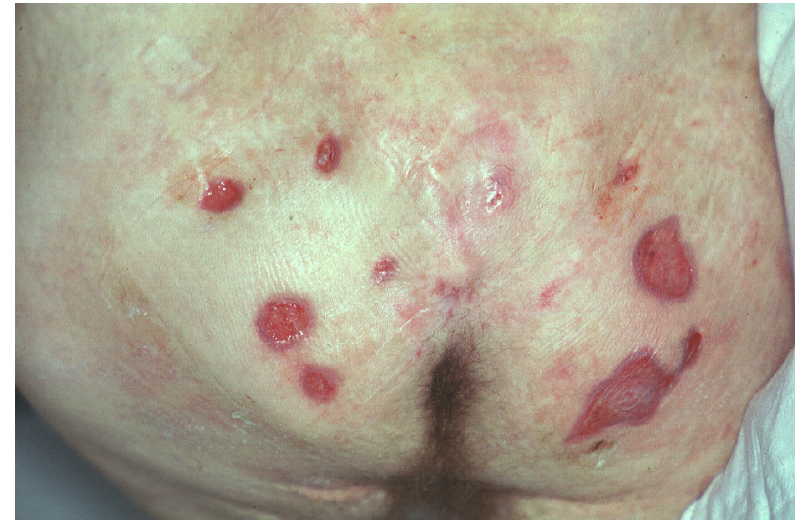
Fig. 4 Amelioration of gluteal abscesses after two months treatment with anti TNF alpha therapy (picture performed in September